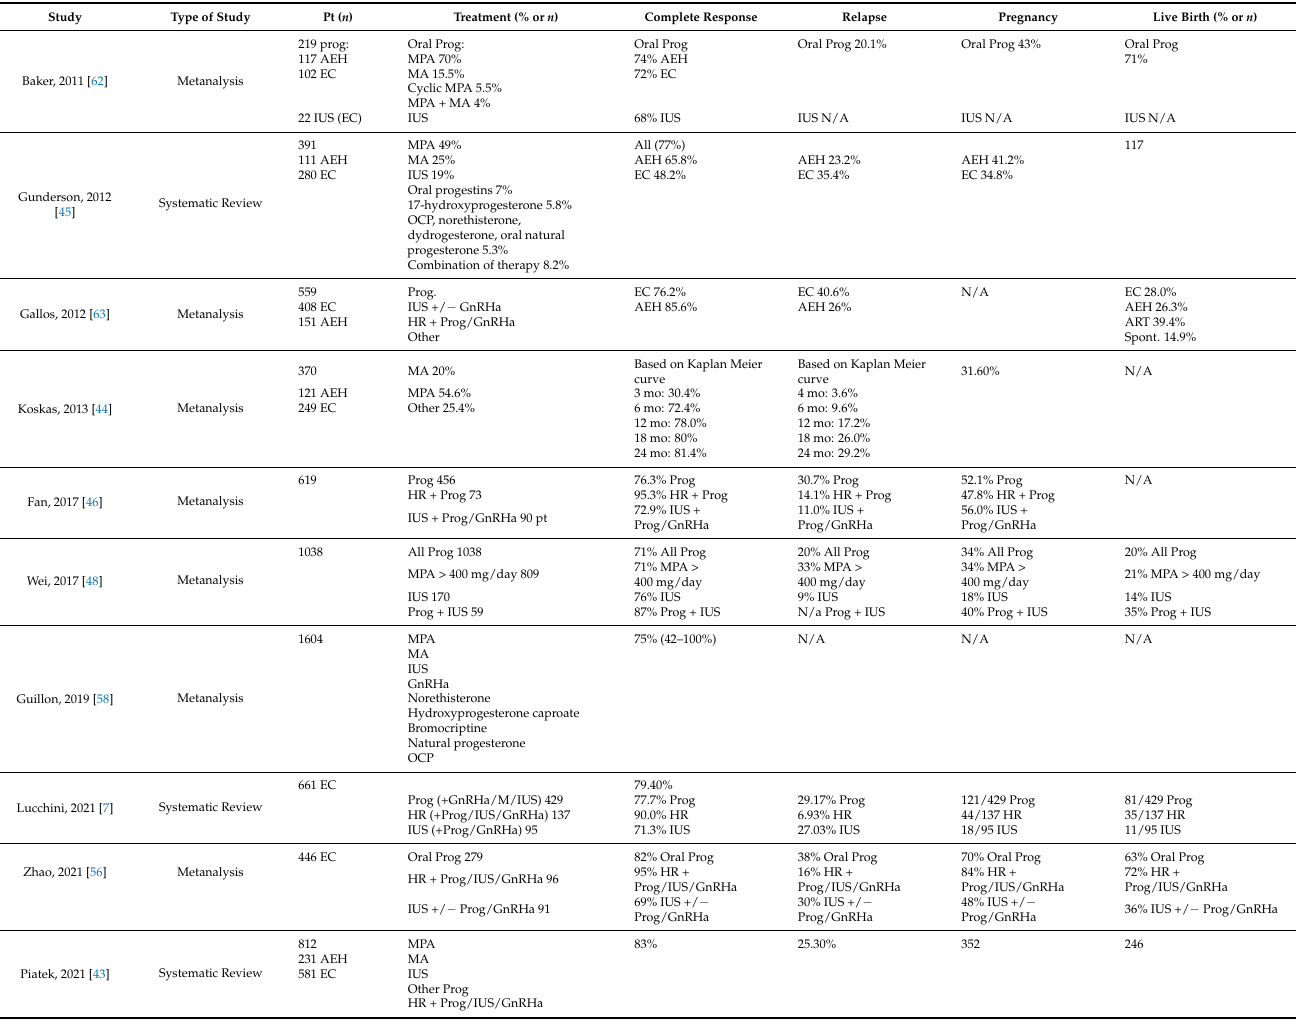
Table 1. Main metanalysis/systemic reviews on progestin therapy for endometrial cancer and atypical endometrial